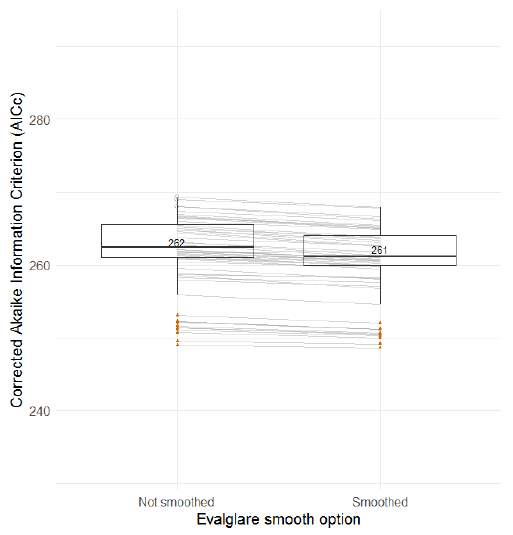
Figure 36. Boxplots of AICc for the non-smooth/smooth parameter (field study). Buildings 2018 , 8 , x FOR PEER REVIEW